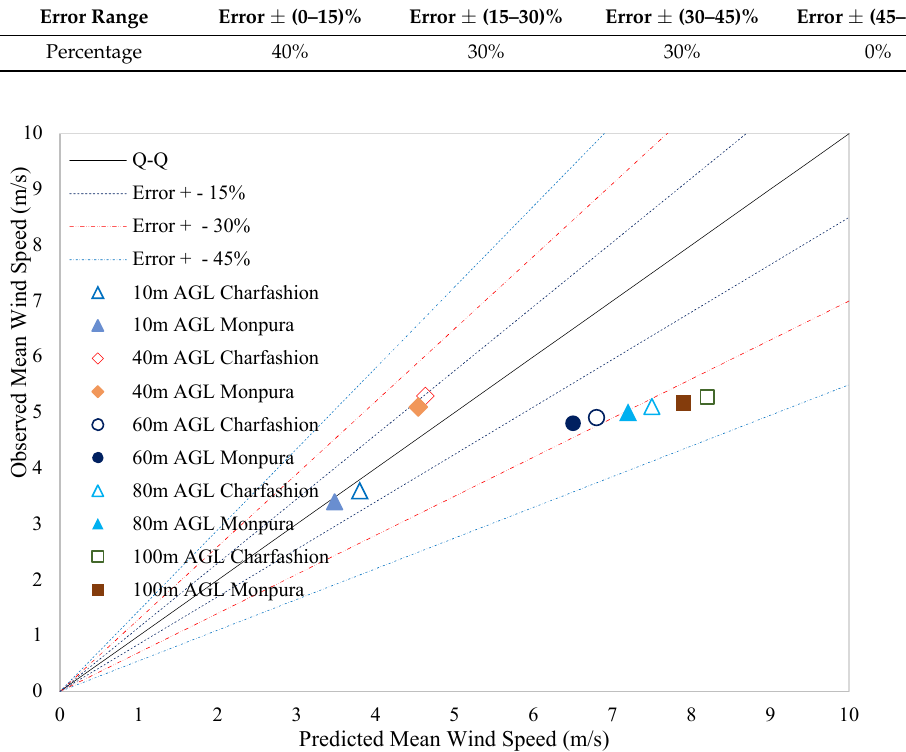
Figure 10. Quantile–quantile plot for the long-term measured and simulated mean wind speeds of the two prospective coastal sites (Charfashion and Monpura).